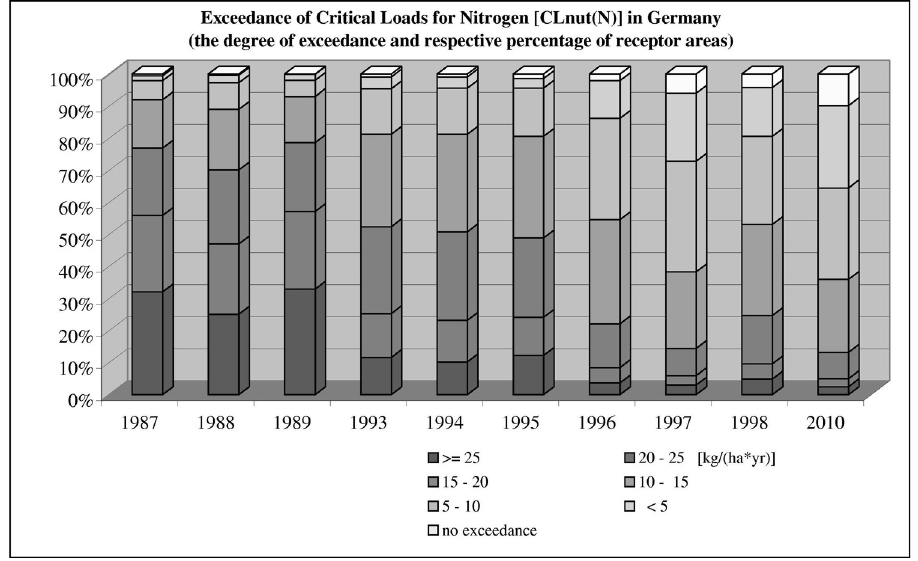
FIGURE 9 . Exceedance of critical loads for nutrient nitrogen determined for 1987–1998 and estimated for 2010, after the full implementation of the Gothenburg